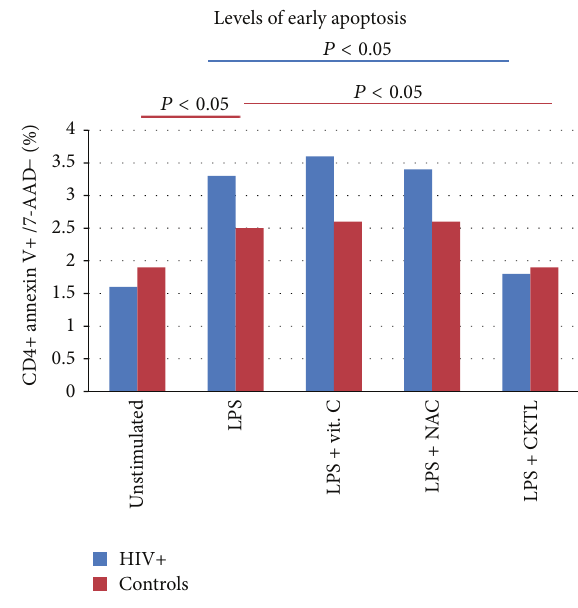
Figure 3: The figure shows the median % annexin V staining on CD4+ T-cells under different experimental conditions for both HIV positive and control groups. LPS induced a significant increase in annexin V staining in the controls ( 𝑃 = 0.007 ) and this increase was significantly reduced in both HIV positive and controls ( 𝑃 = 0.02 ; 𝑃 = 0.008 , resp.) by a combination of vitamin C and NAC. Red and blue lines at the top of the bars indicate significance.